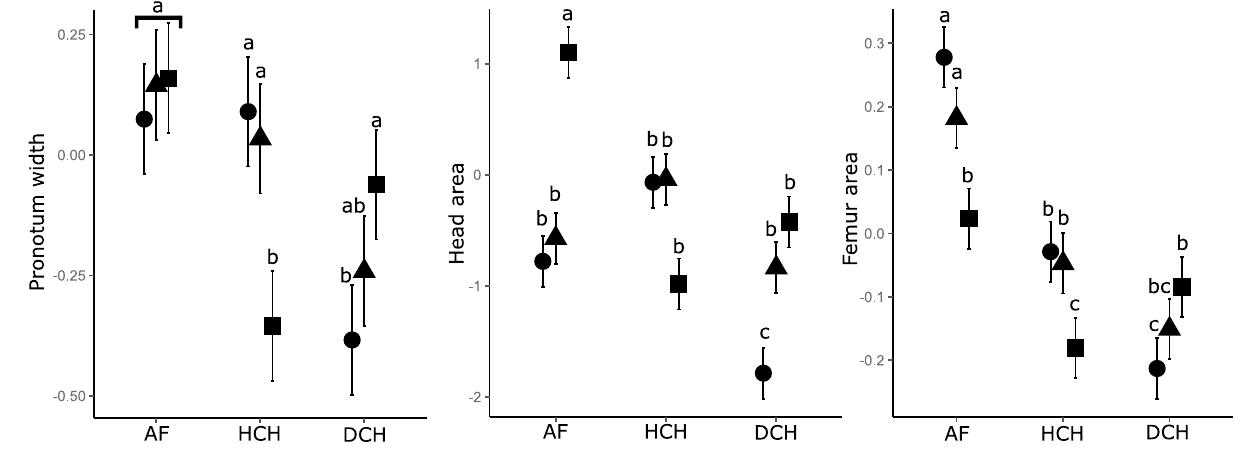
Figure 4. Pronotum width, head area and femur area of dung beetle among different regions and habitat types in subtropical forests of Argentina based on a GLMM analysis. AF: Atlantic Forest, HCH: Humid Chaco, DCH: Dry Chaco. Circles: native forest, triangles: forests with cattle, squares: open pastures. Different letters indicate significant differences ( p < 0.05).